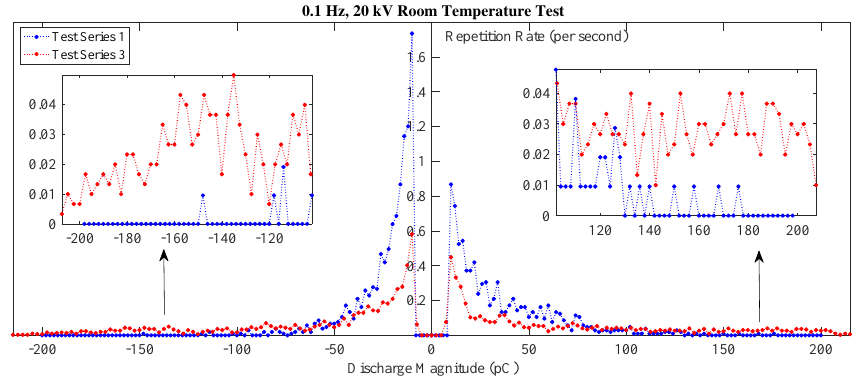
Figure 14. Evidence of void evolution for 0.1Hz AC sinusoidal wave at